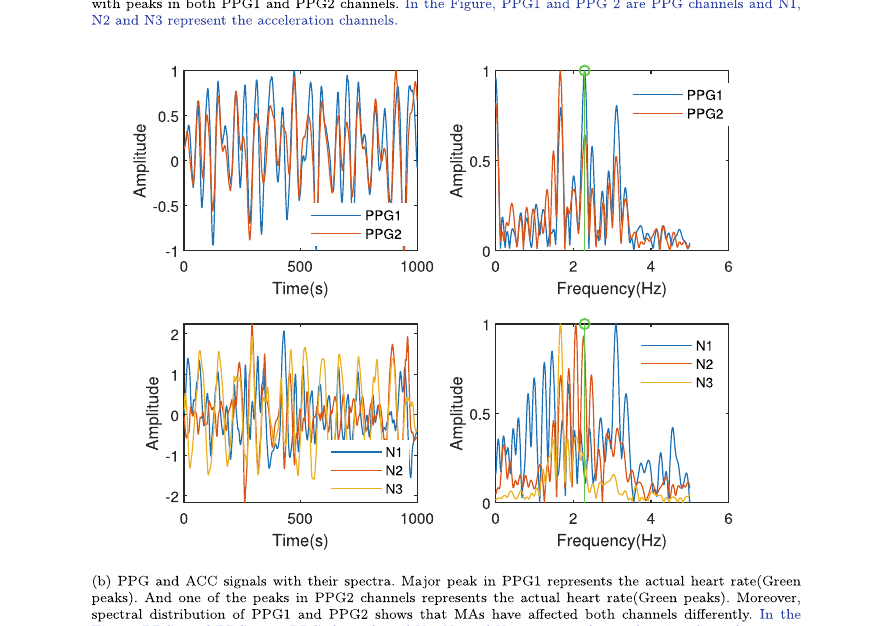
Fig. 2 An example of clean PPG vs PPG affected by MAs